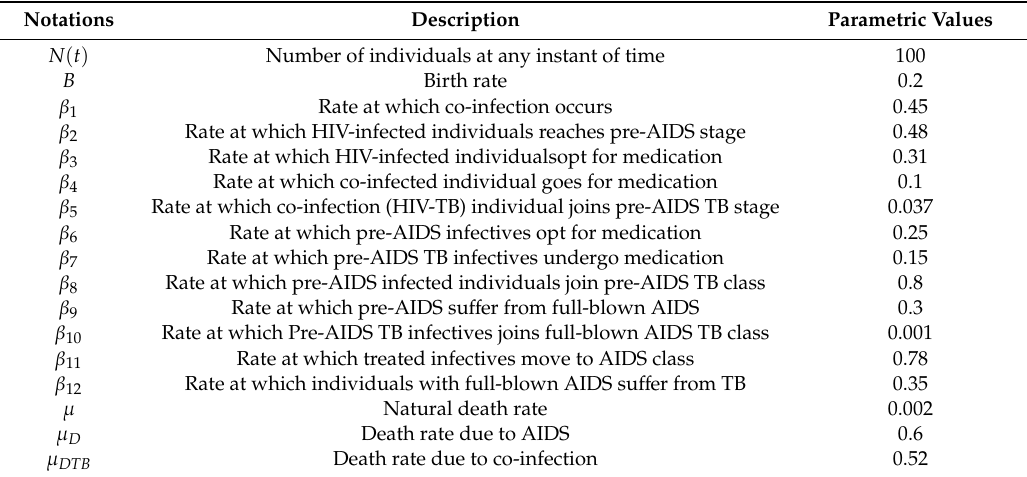
Table 1. Parametric definitions and its